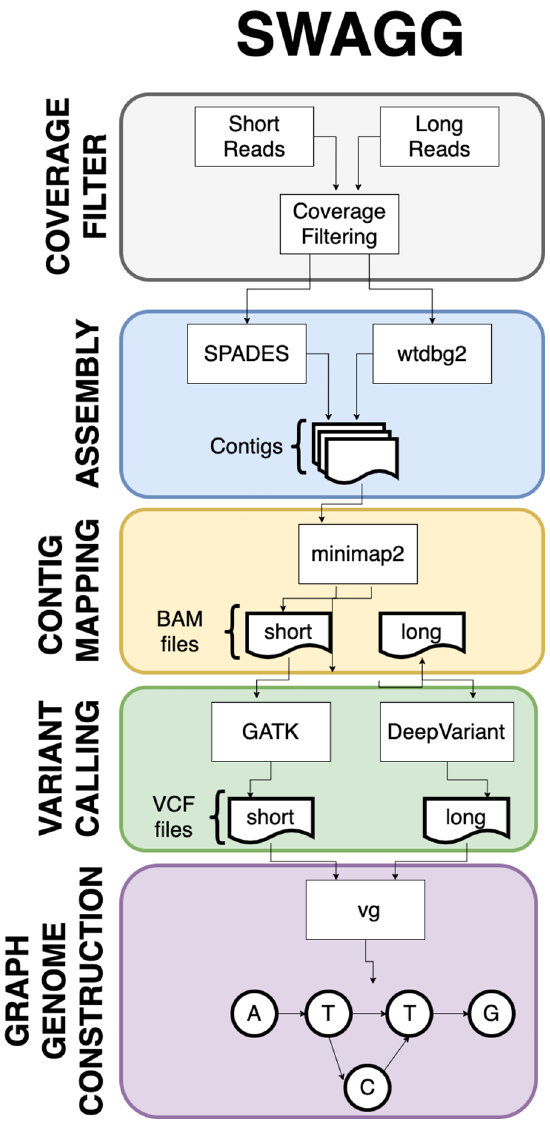
Figure 6. Outline of the SWAGG software package workflow. Illustration of the SWAGG pipeline that utilises both long and short read datasets for the construction of graph application (Figure 8). After entering the gene name (HGNC, Ensembl gene (ENSG), or transcript (ENST) identifier) in the search box on the homepage, the user is directed to the summary of the gene-specific page. GeneVar is available on GitHub (https://github.com/collaborativebioinformatics/GeneVar). The repository provides detailed instructions for tool usage and installation. A bash script for automated installation of the required dependencies is also provided. SVTeaser: SVTeaser is a tool for rapid assessment of SV call fidelity created for geneticists designing experiments to genotype a set of pre-ascertained SVs and bioinformaticians benchmarking a new algorithm against pre-existing tools across a range of parameters (Figure 9). Users are required to supply SVTeaser with a reference sequence file (.fasta) and, optionally, a set of SVs (.vcf). SVTeaser outputs assorted statistical metrics across a range of read lengths and depths. SVTeaser achieves rapid assessment by downsampling the full reference to a subset of numerous 10kb samples to which it adds SVs. XSVLen: This software is a framework for benchmarking SV detection algorithms against haplotype-resolved assem- blies in which variants are validated by comparing sequence content rather than comparing breakpoints of variants (Figure 10). XSVLen validates a VCF file with sequence-resolved variants including those produced by cuteSV or